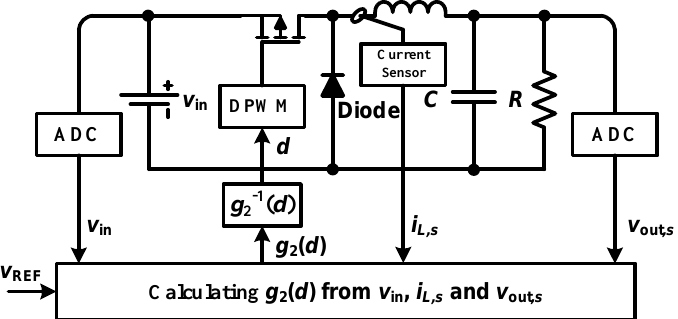
Figure 5. Scheme of the buck converter under Digital Predictive Voltage Programmed (DPVP) control.